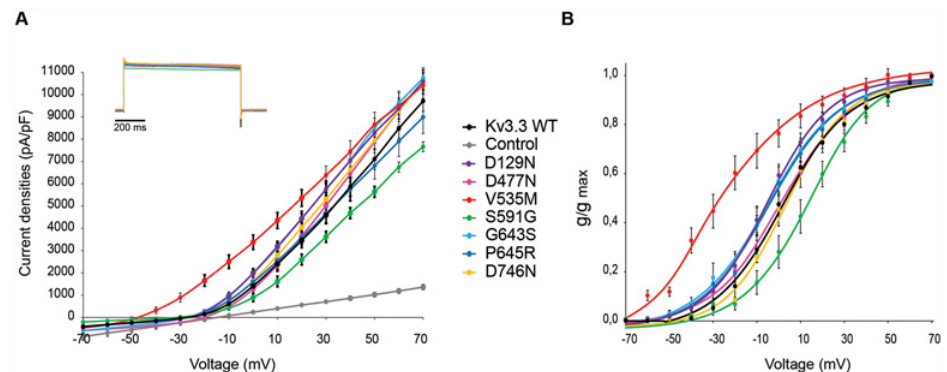
Fig 2. D129N, V535M and S591G variants affect the functional channel properties of Kv3.3. A) Potassium currents recorded from CHO-K1 cells expressing Kv3.3 WT or mutants. Graph shows current amplitudes evoked by pulsing from-70 mV to +70 mV in 10 mV increments and plotted versus voltage for WT (black), D129N (violet), D477N (pink), V535M (red), S591G (green), G643S (light blue), P645R (dark blue), D746N (yellow) and control untransfected cells (grey). Data are provided as mean ± SEM, n = 10. Inset: Representative current traces obtained at +70 mV scaled and overlaid for Kv3.3 WT and mutants. B) Normalized conductance values were plotted versus voltage and are shown as mean ± SEM. Data were fitted with a Boltzmann function to obtain the V 1/2 of activation and the slope factor (Table 2).